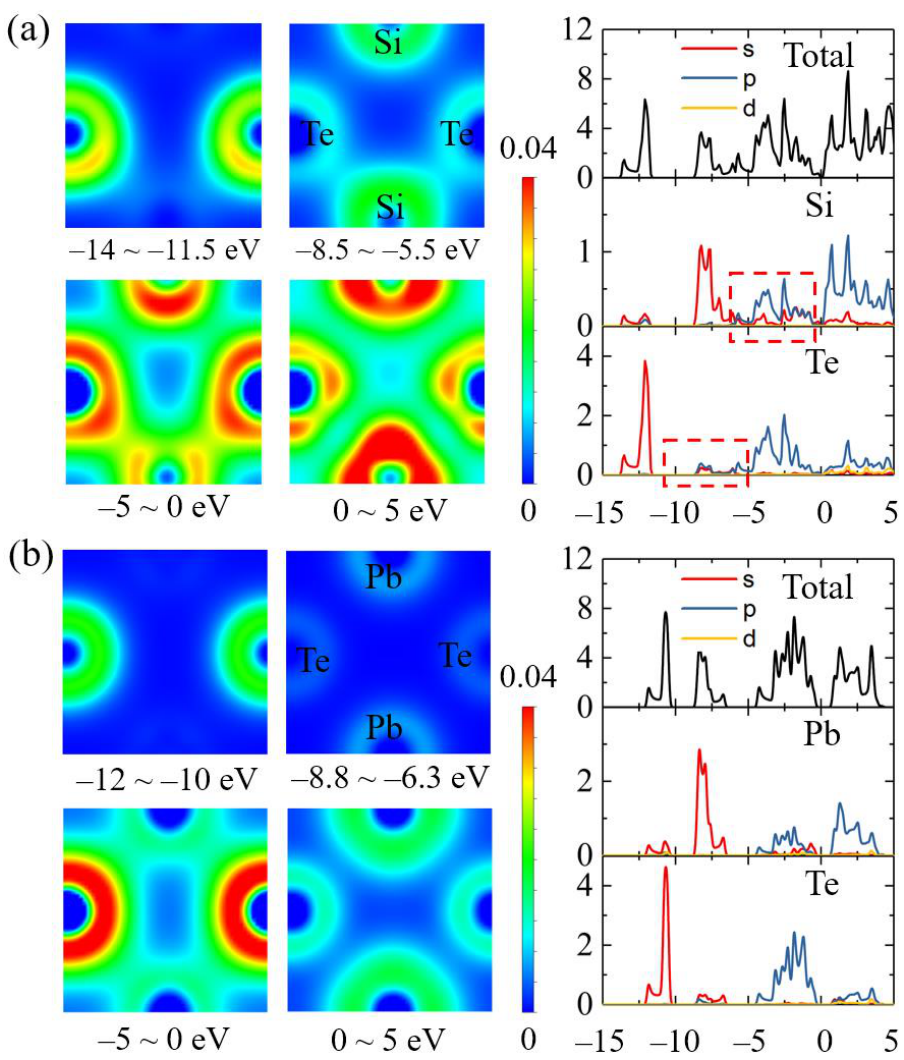
Figure 5. Electronic charge density for different energy ranges of the valence bands and conduction bands, and total and partial density of states for monolayer ( a ) SiTe and ( b ) PbTe. The difference in bonding character is apparent at the top of the valence bands ( − 5~0 eV). For the monolayer SiTe, the electronic charge density exhibited a more co- valent bonding character, corresponding to the hybridization between Si s and p states in this region. However, the bottom region of the conduction bands (0~5 eV) corresponded to the ionicity of the monolayer group-IV tellurides by p–p ionic bonding. For the PbTe monolayer, the electronic charge density at the top of the valence bands showed no obvi- ous charge sharing phenomena between Pb and Te atoms when compared with the SiTe monolayer; conversely, the p–p ionic bonding played a dominant role in this compound. Therefore, covalence and ionicity coexist in all the group-IV telluride monolayers with a black phosphorene-derived structure. For the SiTe monolayer, the s–p covalent bonding played a more important role than ionic bonding, while for the PbTe monolayer, the contri- bution from p–p ionic bonding was greater; thus, the compounds became less covalent and more ionic from SiTe to